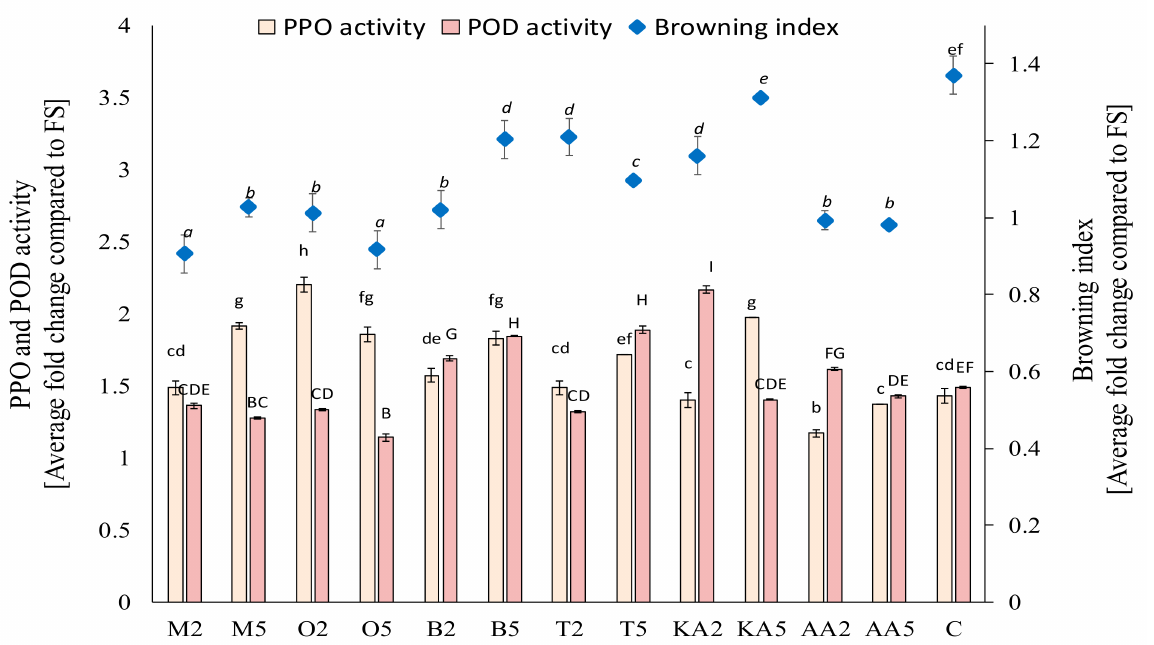
Figure 1. Effect of soaking in different solutions on the browning index and the polyphenol oxidase (PPO) and peroxidase (POD) activity in the control and treated mung bean sprouts after 8 days of storage. Means with different letters (lowercase: PPO activity, uppercase: POD activity, and italics: browning index) are significantly different ( n = 9; α = 0.05). M2, M5: mung bean sprouts soaked in 2IC50 and 5IC50 water extracts of marjoram leaves, respectively; O2, O5: mung bean sprouts soaked in 2IC50 and 5IC50 water extracts of oregano leaves, respectively; B2, B5: mung bean sprouts soaked in 2IC50 and 5IC50 water extracts of basil leaves, respectively; T2, T5: mung bean sprouts soaked in 2IC50 and 5IC50 water extracts of thyme leaves, respectively; KA2, KA5: mung bean sprouts soaked in 2IC50 and 5IC50 solutions of kojic acid; AA2, AA5: mung bean sprouts soaked in 2IC50 and 5IC50 solutions of ascorbic acid; C: mung bean sprouts soaked in distilled water, FS: fresh